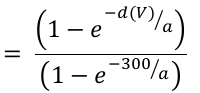
Fig. 8. Charge Collection Efficiency from laser data, fit to a penetration length of 167μm and data for a MIP electron calculated in EXERCISE 6 for comparison .